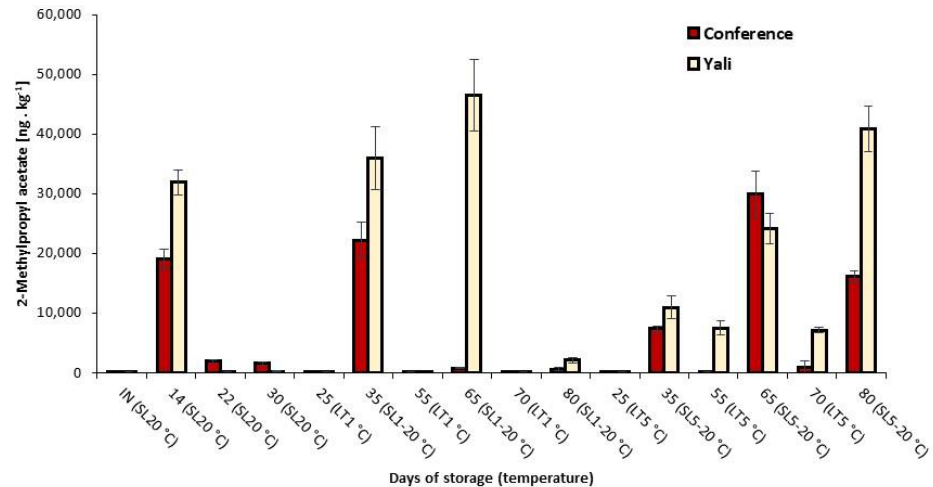
Figure 4. Concentration changes of 2-methylpropyl acetate in ‘Conference’ and ‘Yali’ pear cultivars depending on time and storage regimes. (SL20 °C — shelf-life at 20 °C; LT — low storage at 1 or 5 °C; SL1-20 °C, SL5-20 °C — shelf-life at 20 °C after storage at 1 or 5 °C).